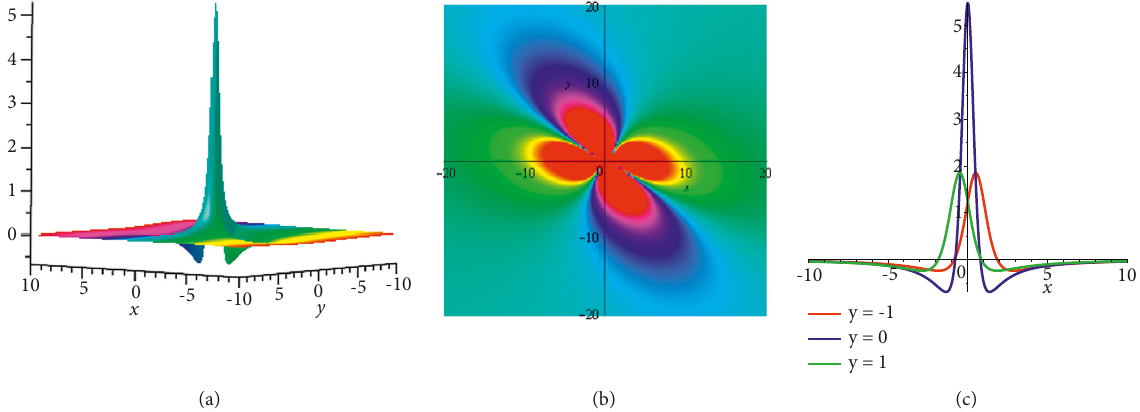
Figure 2: Plot of equation (44) by taking a � 0 . 5 , b � − 1 . 1 , c